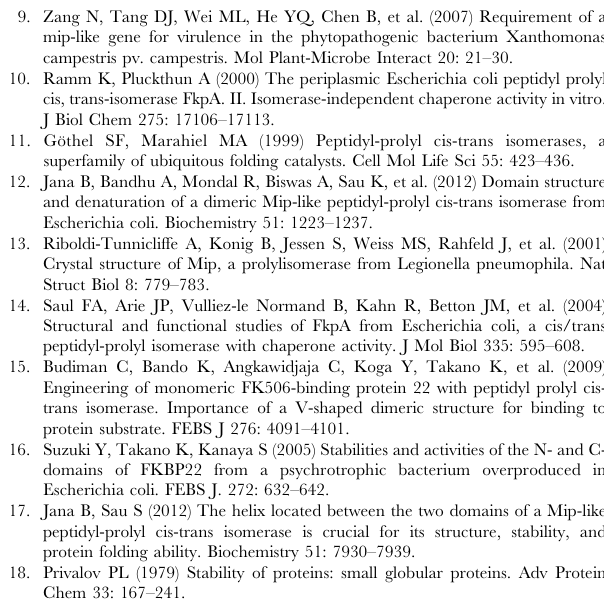
Figure S2 Intrinsic Trp fluorescence spectra of pro- teins. The intrinsic Trp fluorescence spectra of the indicated proteins (saturated/unsaturated with FK506) were recorded at 25 u C. Figure S3 Alignment of the Mip-like proteins. The indicated Mip-like proteins were aligned by ClustalW program. Figure S4 Urea-induced unfolding of the rapamycin- bound/unbound rFKBP22 and CTD + . The far-UV CD (A- D) and intrinsic Trp fluorescence spectra (E–H) of the indicated proteins in the presence of 0–7 M urea are shown. Figure S5 Refolding of the urea-treated proteins. The indicated proteins (pre-equilibrated with/without rapamycin) were denatured with 7 M urea followed by their analysis using the transverse urea gradient polyacrylamide gel electrophoresis (A–D).